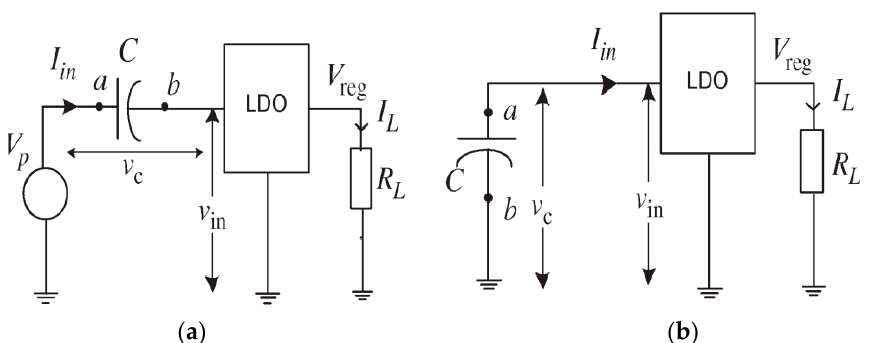
Figure 13. Concept of supercapacitor energy recovery: ( a ) minimizing the series element dissipation; ( b ) reuse of stored energy in the supercapacitor [24].